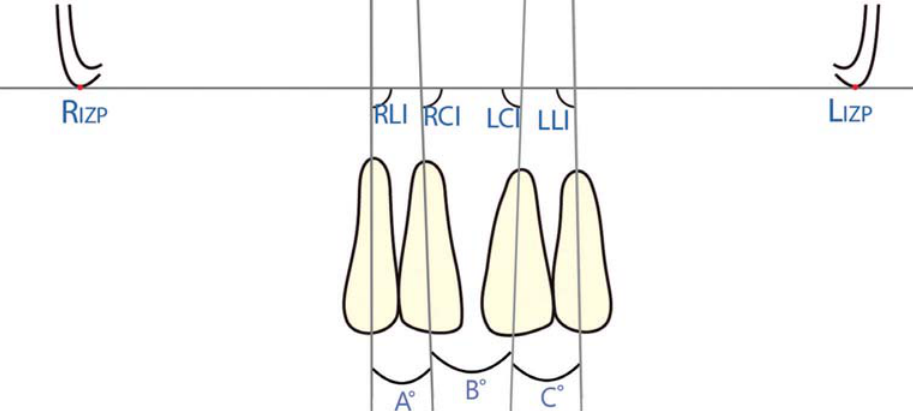
Figure 2- Panoramic radiographic tracing showing the angles built by root long axes of the maxillary incisors and the intermaxillary-zygomatic-processes (IZP) line, and the angles between adjacent